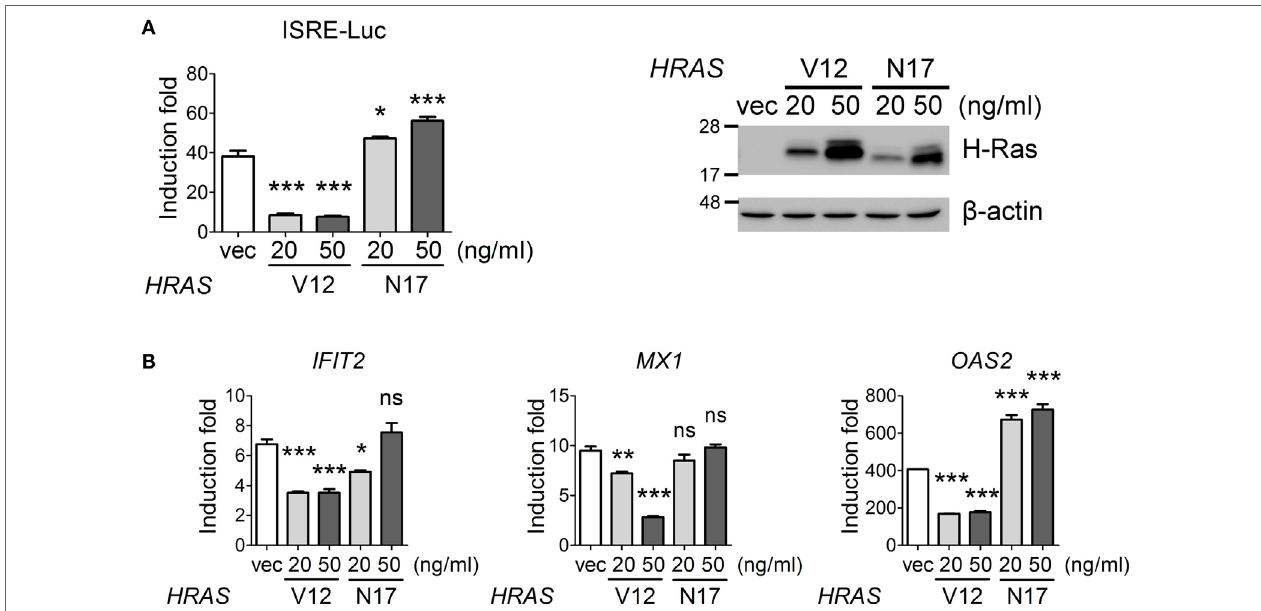
FigUre 6 | Oncogenic H-Ras inhibits type I interferon signaling. (a) HEK293T cells were transfected with vector, HRAS V12, or HRAS N17 DNA at the indicated doses together with the pISRE-Luc reporter plasmid and the pTK-RL reporter plasmid. In all groups, the total amounts of transfected DNA were adjusted to the same using the control vector DNA. Cells were treated with or without IFN- α (1,000 U) at 24 h post-DNA transfection, and luciferase activities were measured at 24 h post IFN- α treatment. The expression levels of transfected H-Ras are shown on the right. (B) The RNA transcription levels of IFIT2 , MX1 , and OAS2 were determined by RT-qPCR and the induction folds were calculated as ΔΔ Ct. All the results of induction fold were obtained from three independent experiments and presented as the mean ± SD. * P < 0.05, ** P < 0.01, and *** P < 0.001 between the indicated groups and the vector-transfected group (one-way ANOVA followed by Dunnett’s post hoc